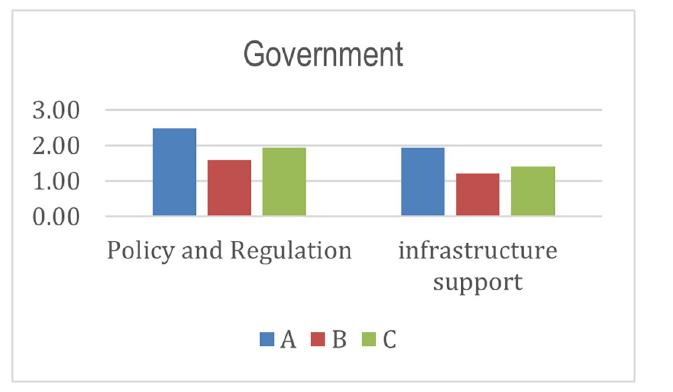
Fig 10. Index score of